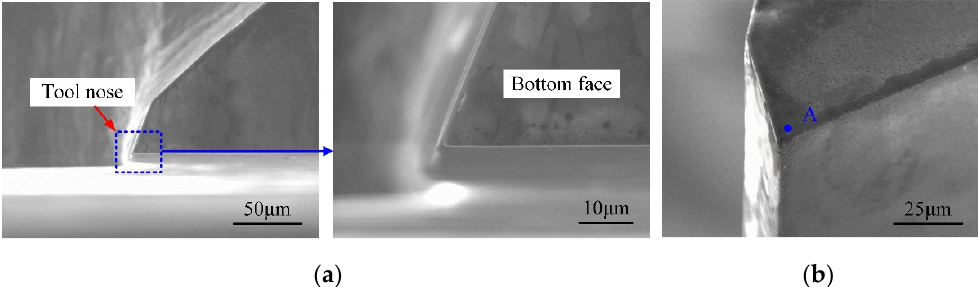
Figure 15. Tool wear of the self-fabricated PCD micromilling cutter. ( a ) Top view of bottom surface; ( b ) Tool nose area.